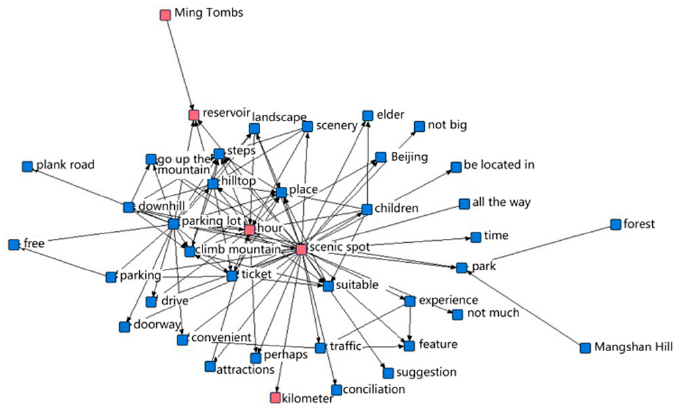
Figure 16. The semantic network for the Yan Mountain landscape.